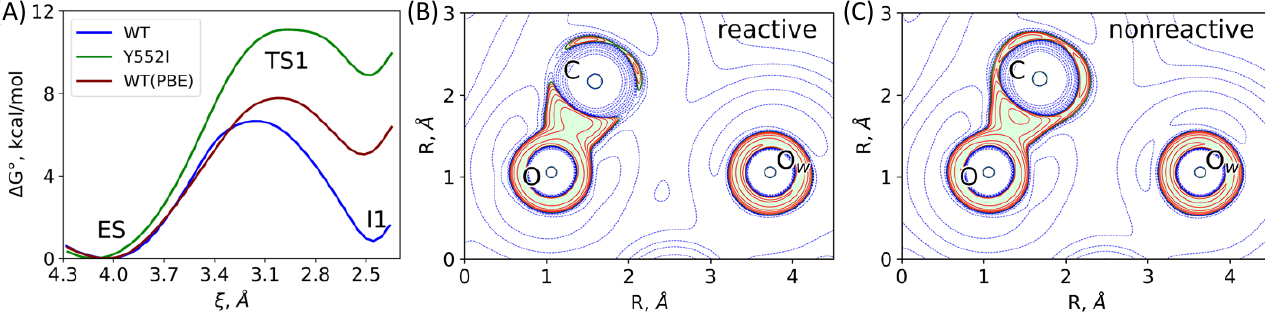
Figure 7. ( A ) The Gibbs energy profiles of the first reaction step calculated for the WT and Y552I GCPII and at the PBE0 level and for the WT enzyme at the PBE level. For the reaction coordinate notation see Figure 4E. ( B ) Reactive and ( C ) nonreactive ES complexes derived from the Laplacian of the electron density analysis in the plane of the carbonyl group of the substrate (C and O atoms) and an oxygen atom, O w , of the catalytic O w H − . Contour lines for the Laplacian of electron density maps are ±(2; 4; 8)·10 n au, −2 ≤ n ≤ 1, blue dashed contour lines indicate the electron density depletion areas ( ∇ 2 ρ ( r ) > 0) and red solid lines identify the electron density concentration ( ∇ 2 ρ ( r ) < 0), green solid line corresponds to ∇ 2 ρ ( r ) = 0. The area with ∇ 2 ρ ( r ) < 0 is colored in